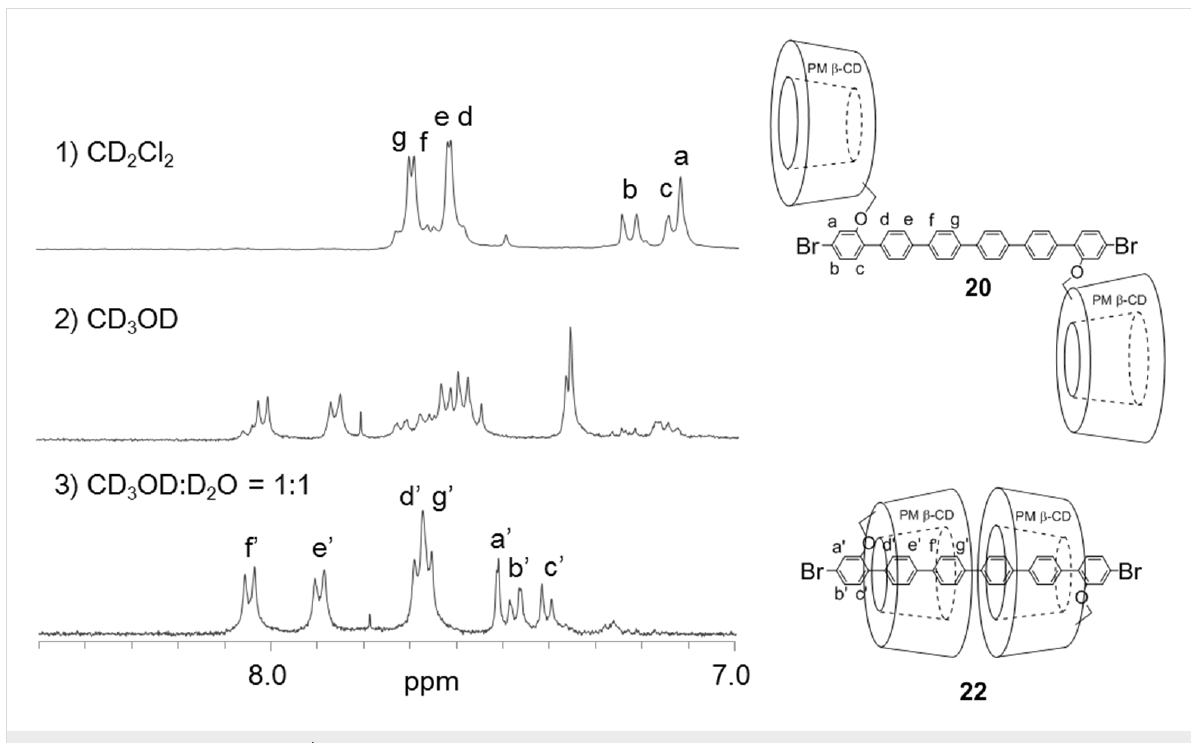
Figure 5: The aromatic region of the 1 H NMR spectra of 20 at 25 °C: 1) CDCl 3 , 2) CD 3 OD, and CD 3 OD/D 2 O 1:1.